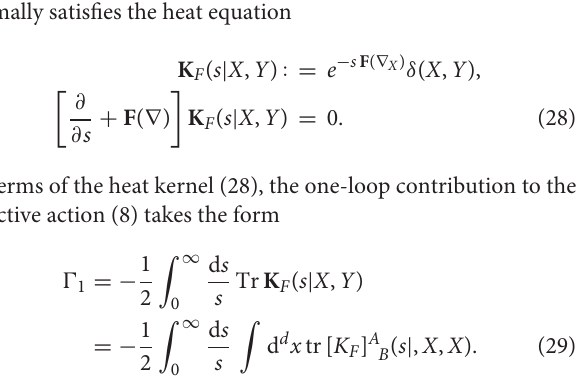
TABLE 1 | Coincidence limits required for the calculation of a 2 ( X , X